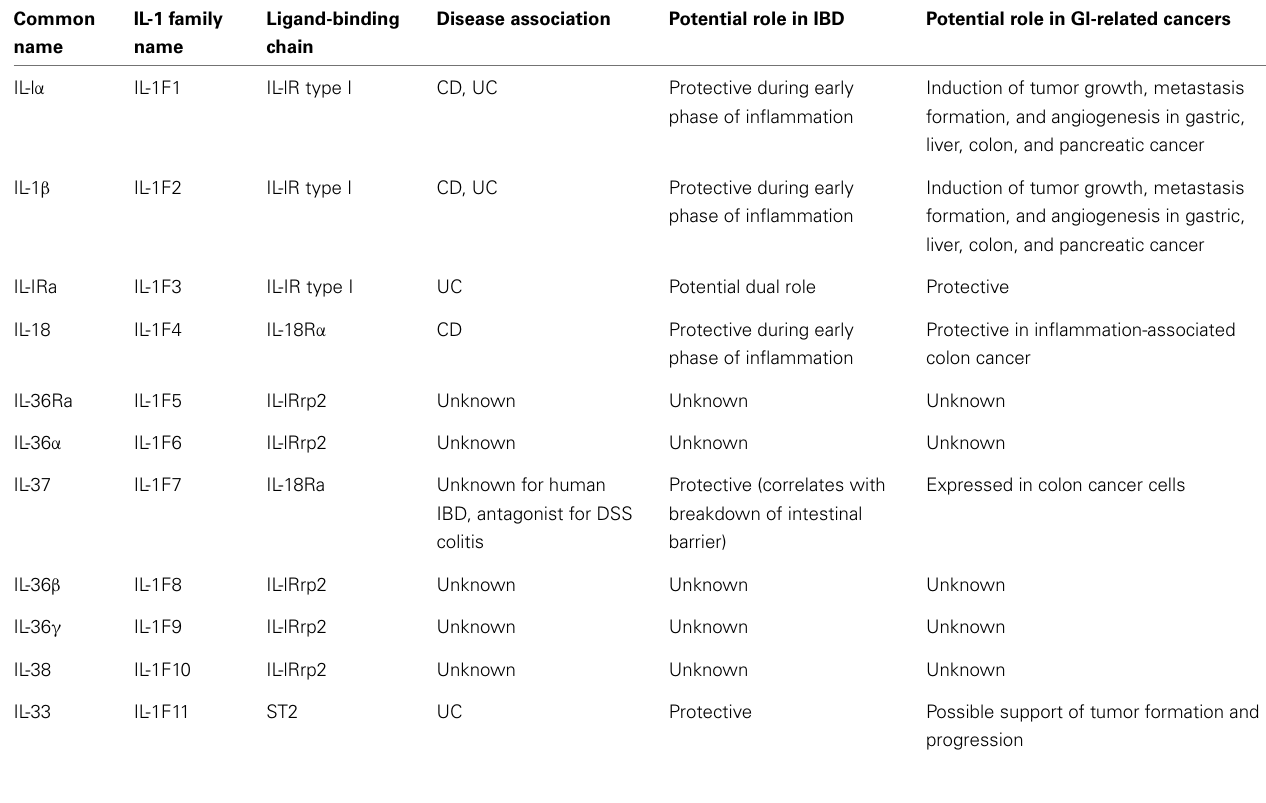
Table 1 | Role of IL-1 cytokine family members in IBD and in GI-related cancers.